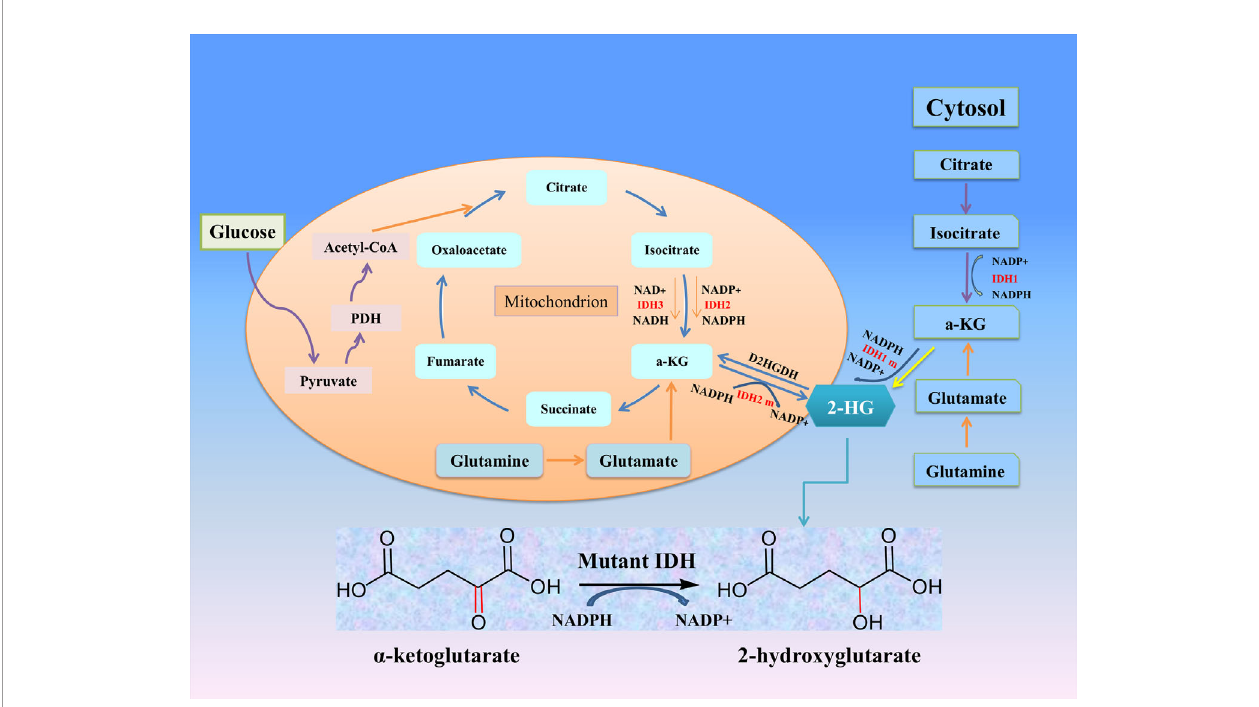
( Table 1 ). The active forms of IDH1 and IDH2, which depend on nicotinamide adenine dinucleotide phosphate (NADP +), are homodimers with similar structures: a large domain, a small domain and a clasp domain (13). And human IDH1 and IDH2 genes are located on chromosomes 2q33.3 and 15q26.1, which encode a 414-amino-acid and a 452-amino-acid (14). IDH3 is a heterooctamer whose activities are dependent on nicotinamide adenine dinucleotides (NAD+), formed by two a subunits (IDH3 a ), one b subunit (IDH3 b ), and one g subunit (IDH3 g ), which are encoded by the IDH3A (15q25.1-2), IDH3B (20p13), and IDH3G (Xq28) genes, respectively (15, 16). Subcellular localizedly, IDH1 is mainly located in cytoplasm and peroxidase, while IDH2 and IDH3 are mainly located in mitochondria.